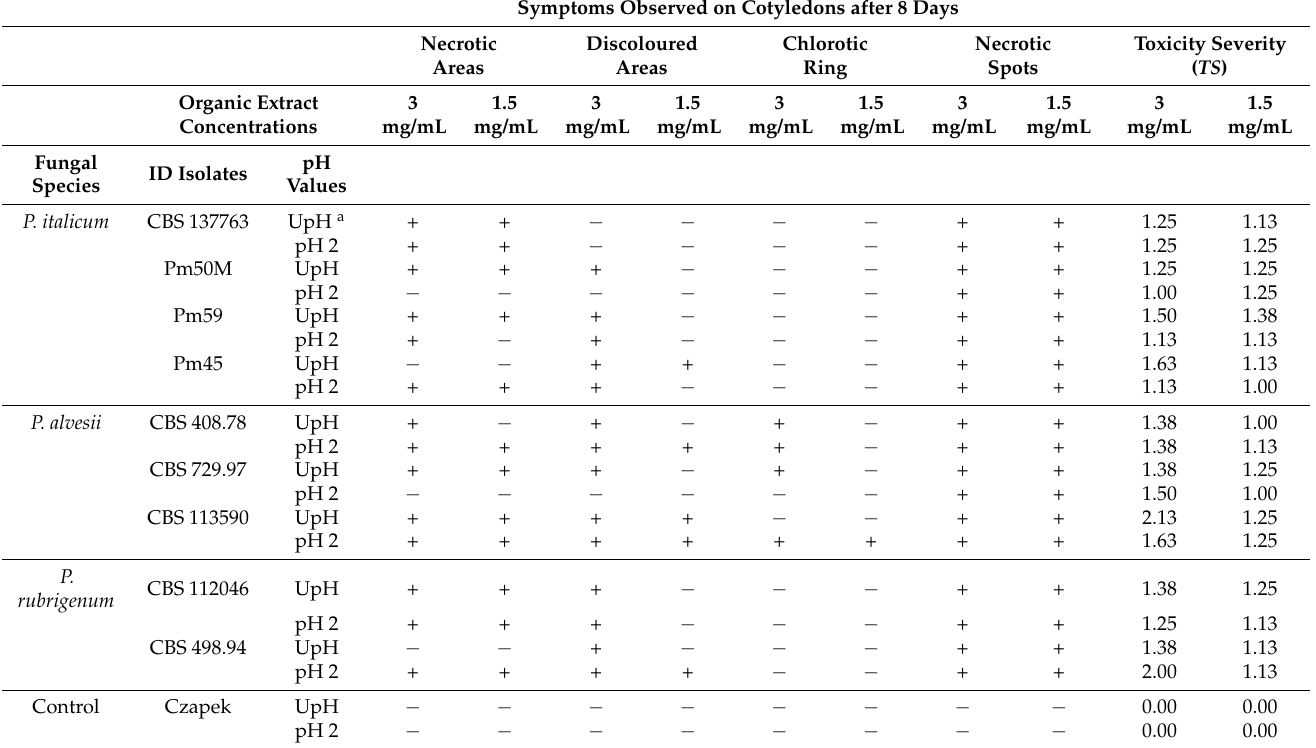
Table 3. Phytotoxic bioassay carried out on Cucumis sativus cotyledons with organic extracts from Phaoacremonium isolates. Symptoms Observed on Cotyledons after 8 Days Necrotic Discoloured Areas Areas